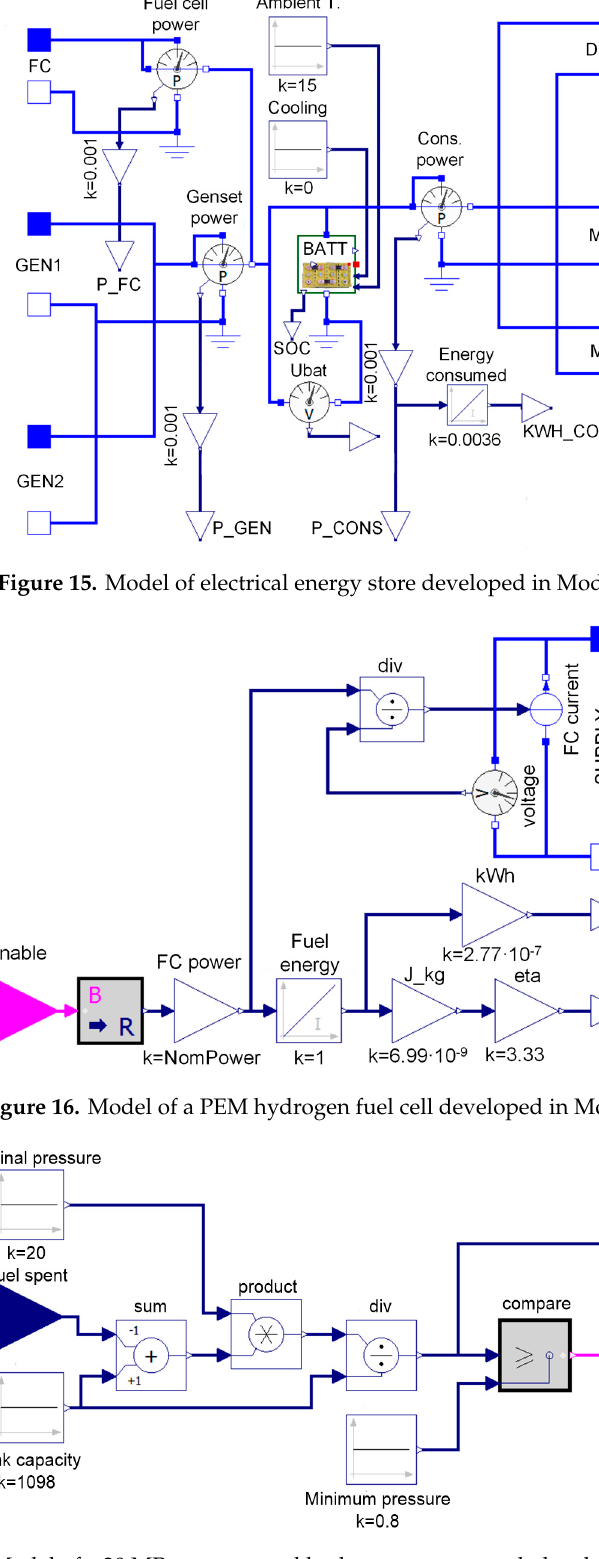
Figure 17. Model of a 20 MPa compressed hydrogen storage tank developed in Modelica.